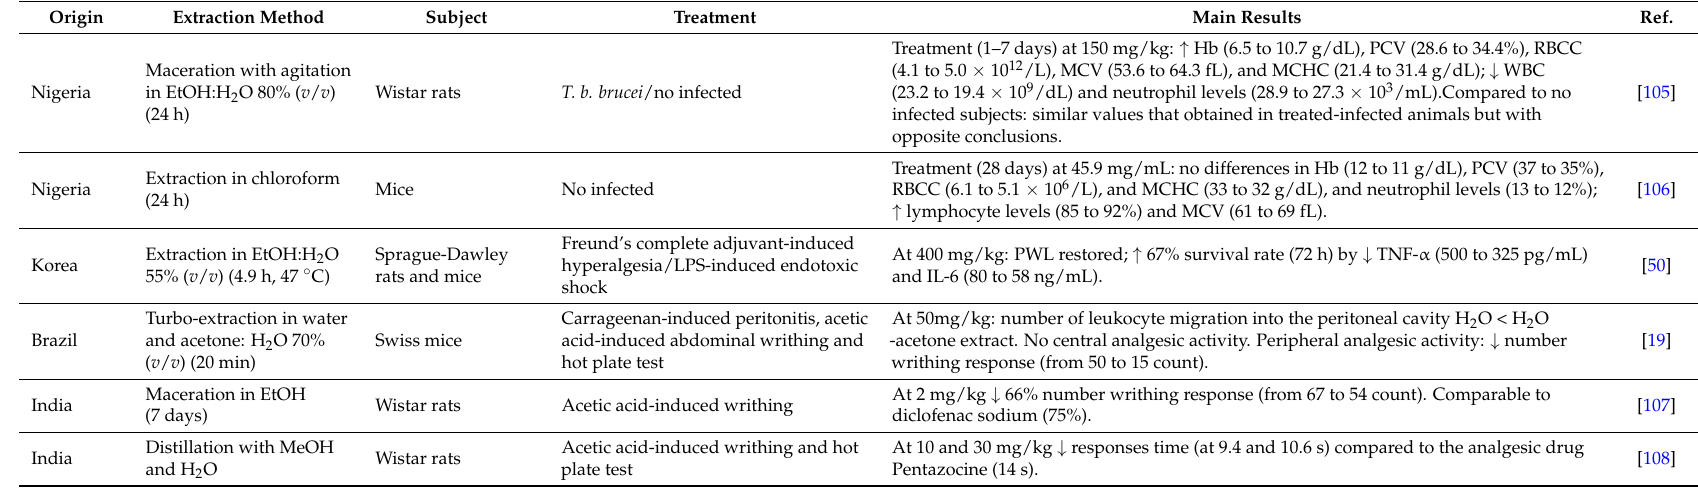
Table 7. In vivo studies against diseases of the blood and immune